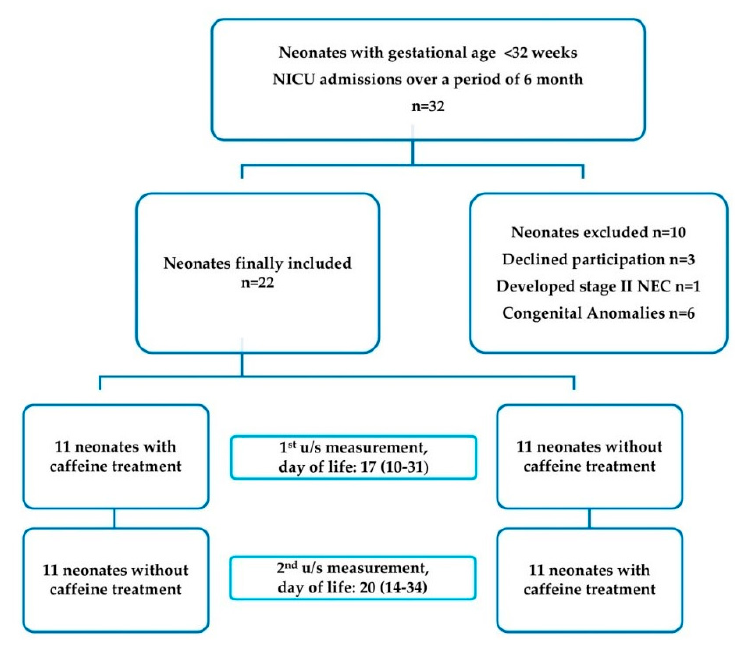
Figure 1. Flow chart of study population.